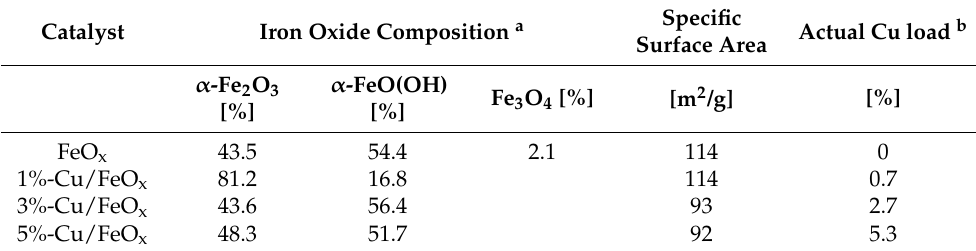
Table 1. Fractions of various forms of iron oxide components in the fresh catalysts, obtained from XRD data using Rietveld refinement of analysis and specific surface area of fresh catalysts, as determined from adsorption/desorption of nitrogen on the surface of the fresh catalysts. Multipoint BET was assessed using Roquerol’s